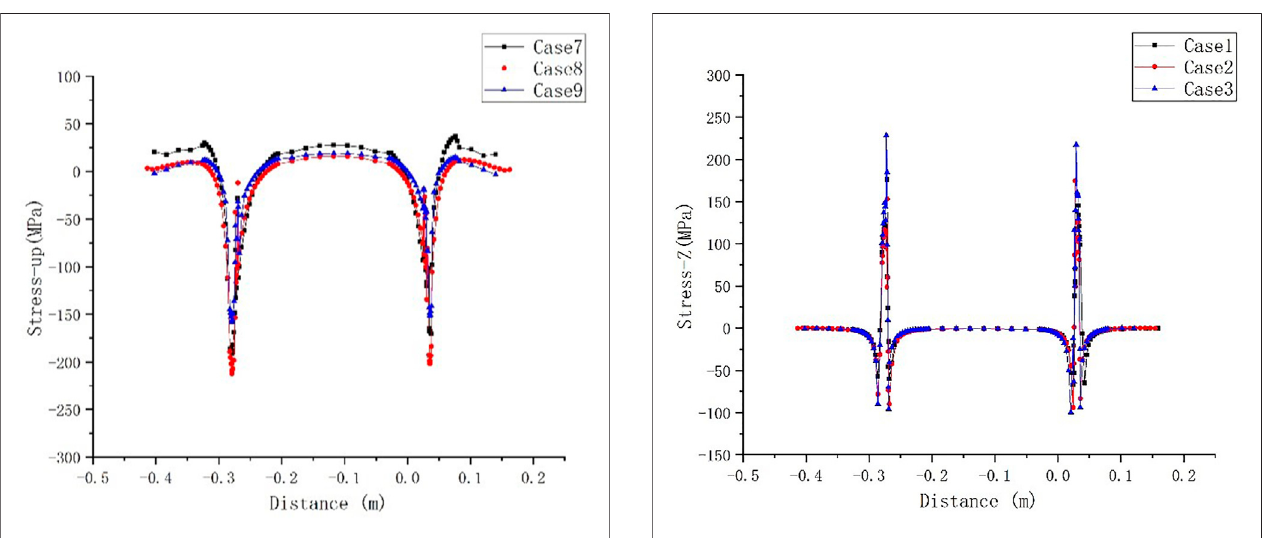
σ z along the z -direction (t1 = 6